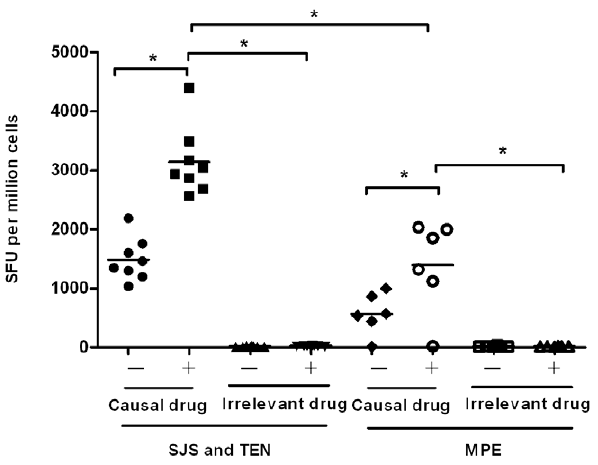
Figure 1. Cultured IFN- c ELISpot responses to causal drugs. PBMCs from patients with SJS and TEN or MPE were incubated with either causal drugs or irrelevant drugs for 10 days. The cells were subsequently washed, and then stimulated with causal drugs or irrelevant drugs in an IFN- c ELISpot assay. Responses are presented as number of IFN- c -positive spot-forming units (SFU) per million cells. Each data point represents an individual patient with SJS and TEN or MPE. Median is indicated by a horizontal line. * P , 0.01 .